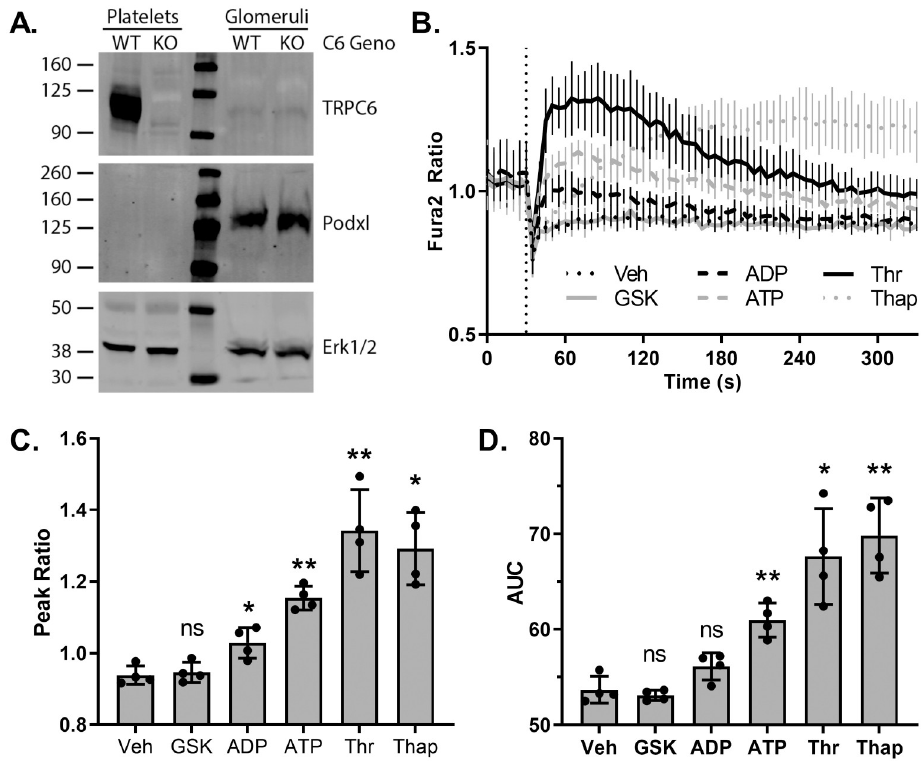
Fig 6. Characterization of TRPC6 expression and GSK1702934A response in murine podocytes. A, platelet and glomerular lysates from wild-type (WT) and Trpc6 -/- (KO) female animals were analyzed by SDS-PAGE and Western blot. Anti-TRPC6 antibodies (top) detected a major band around 105 kD in WT, but not KO, platelets. No corresponding specific band is seen in glomerular lysates. A faint band of a size similar to TRPC6 is seen in both WT and KO glomerular samples, suggesting a non-specific signal. Podocalyxin (Podxl, middle) and Erk1/2 (bottom) blots are shown as loading controls. B, time-course of Fura-2 fluorescence ratio (340/380) in primary podocytes cultured from Trpc6 E896K/E896K (KI) glomeruli. After 30 seconds (dashed vertical line), cells were stimulated with vehicle (Veh), GSK1702934A (GSK; 50 μ M), ADP (100 μ M), ATP (100 μ M), thrombin (Thr; 0.5 u/ml), or thapsigargin (Thap; 1 μ M). Shown are mean ± SD; n = 4 using podocytes from 2 different animals. Post-stimulation (C) peak Fura-2 fluorescence ratio, and (D) area under the curve (AUC, arbitrary units) were calculated. Shown are the mean and values from individual experiments. RM one-way ANOVA with Dunnett’s multiple comparisons test to vehicle